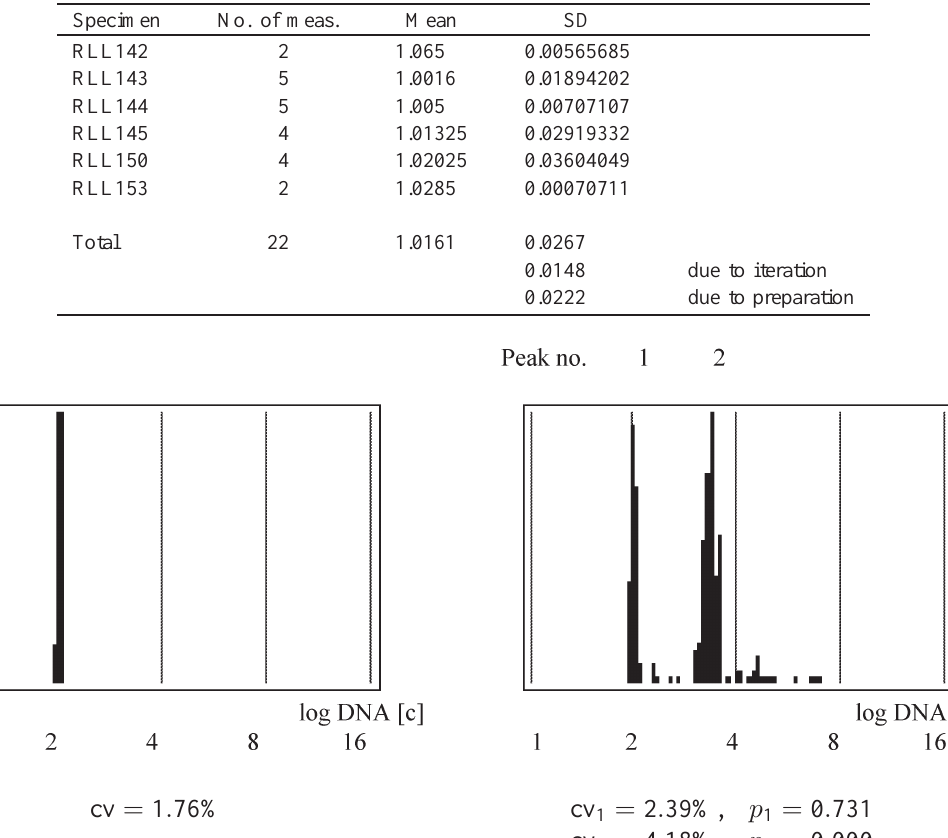
Table 3 Ratio (cf) between 2c hepatocytes and internal reference cells in repeated measurements